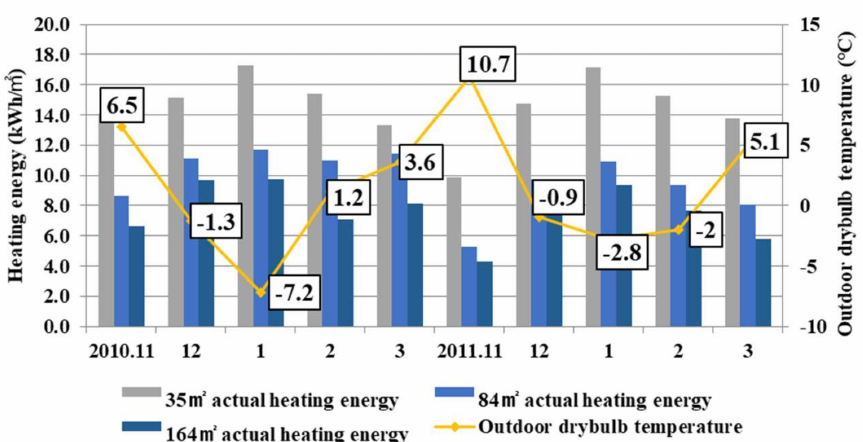
Figure 5. Comparison between the measured monthly average heating energy consumption by house size and the outside